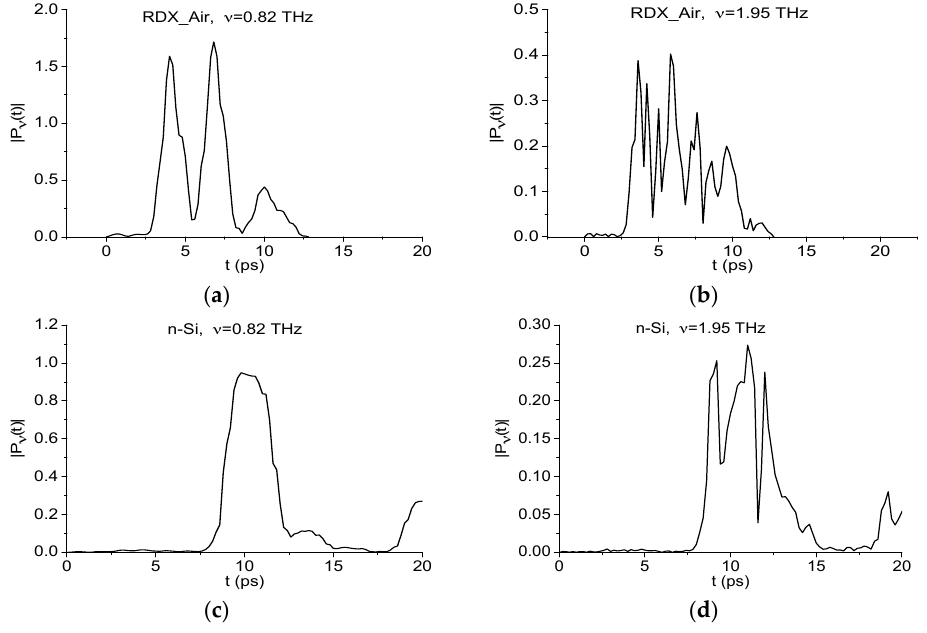
Figure 10. Dynamics of spectral lines of the RDX_Air ( a , b ) and n-Si ( c , d ) signals at frequencies ν = 0.82 THz ( a , c ), 1.95 THz ( b , c ).